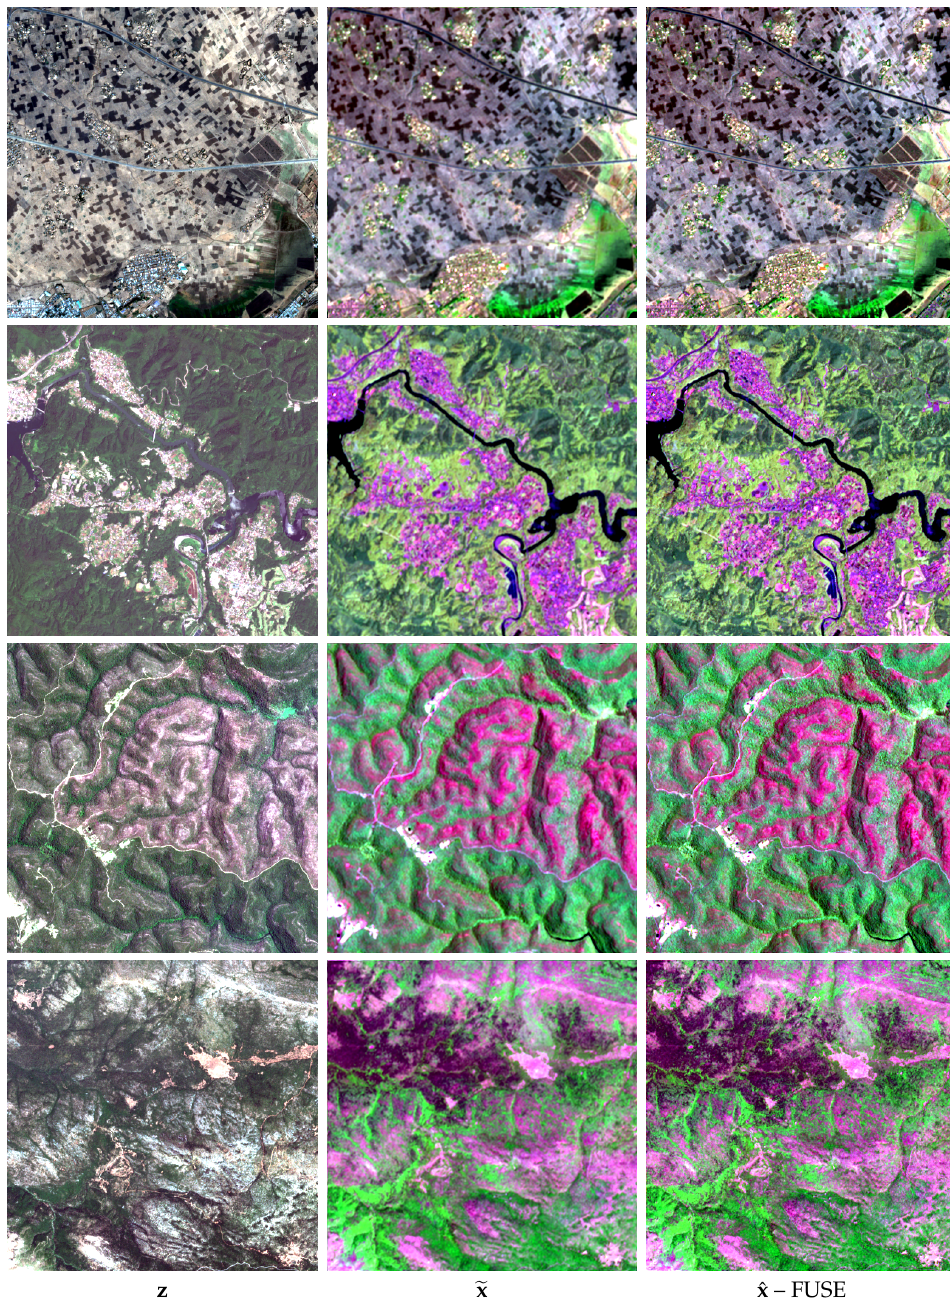
Figure 5. Super-resolution of the test images—Extra-urban zones. From top to bottom: Adis Abeba, Tokyo, Sydney, and Athens. From left to right: High-resolution 10 m input component z , low-resolution x to be super-resolved, and super-resolution ˆ x using the FUSE 20 m component (cid:101)